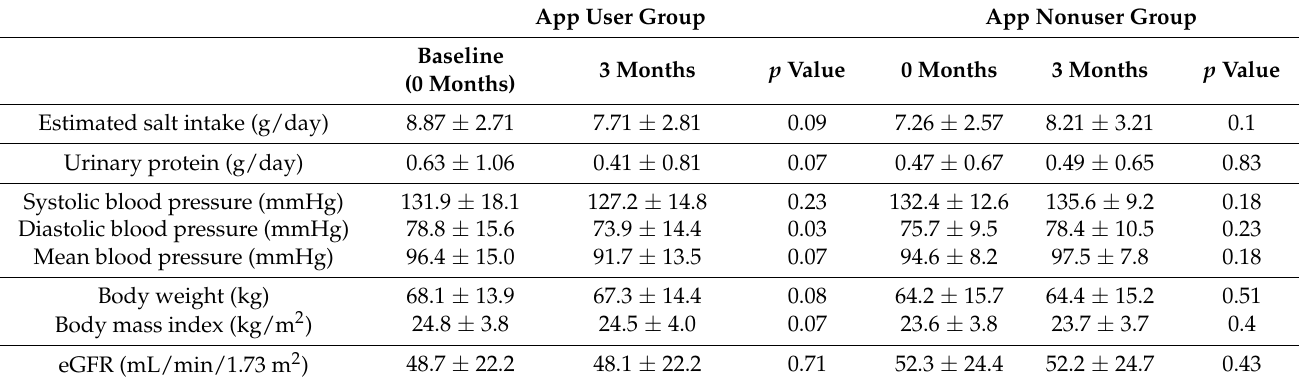
Table 2. Within-group comparisons of parameters obtained at baseline and after 3